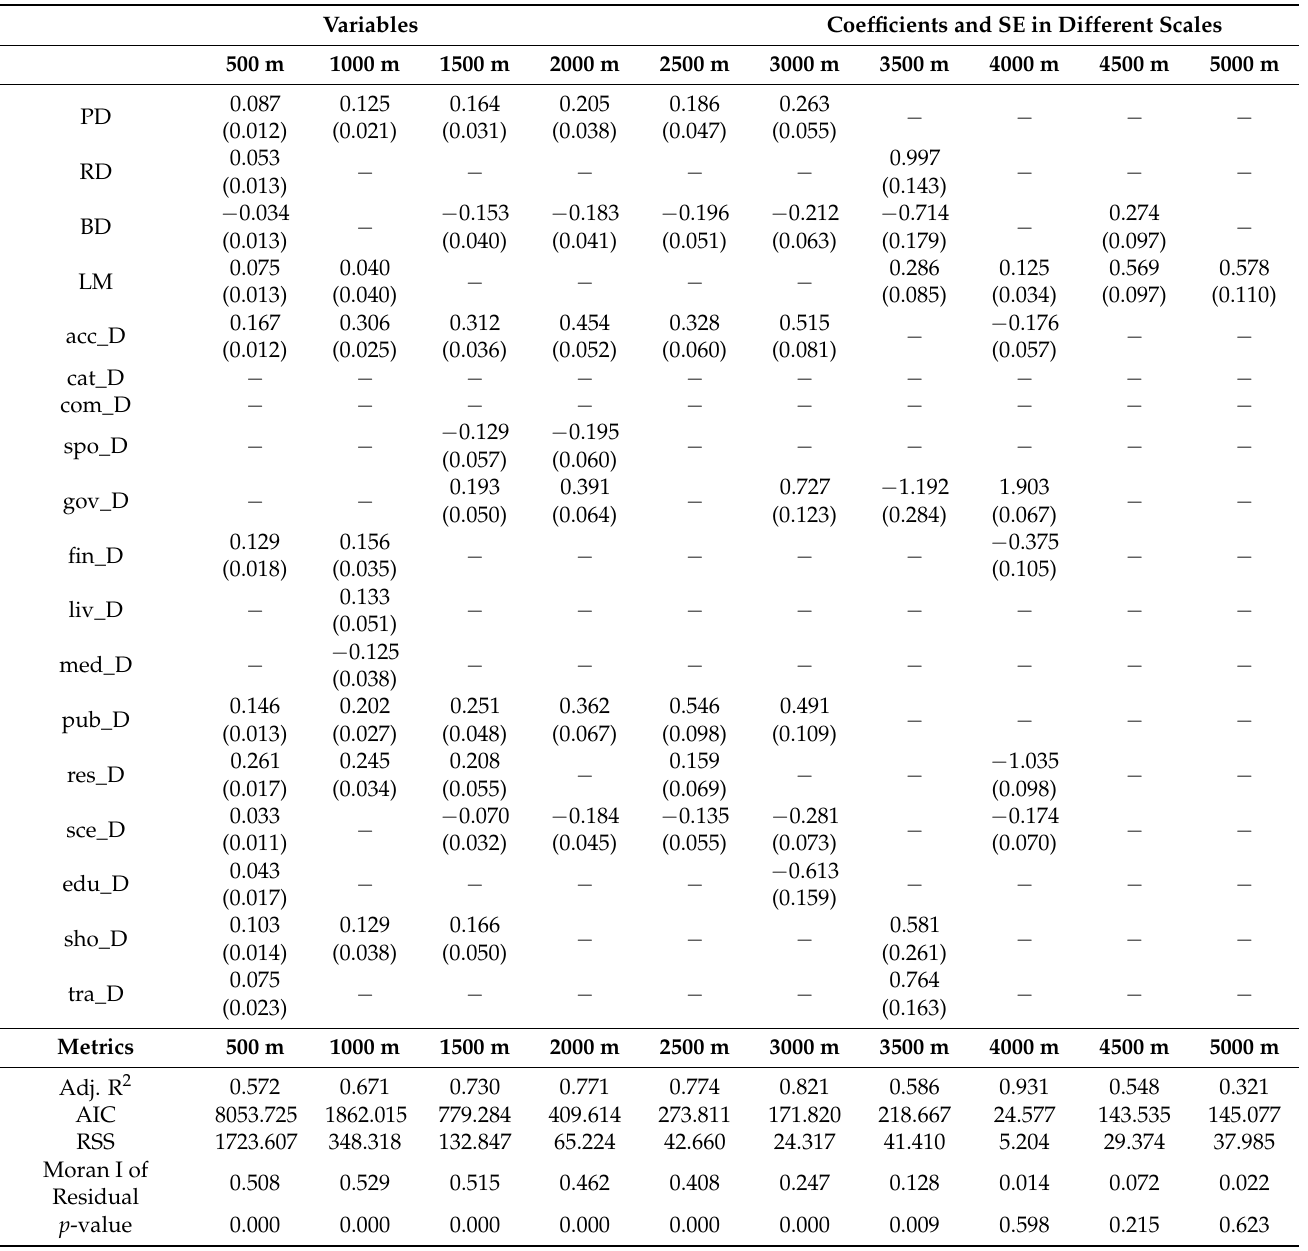
Table 4. The regression results of OLS model in ten